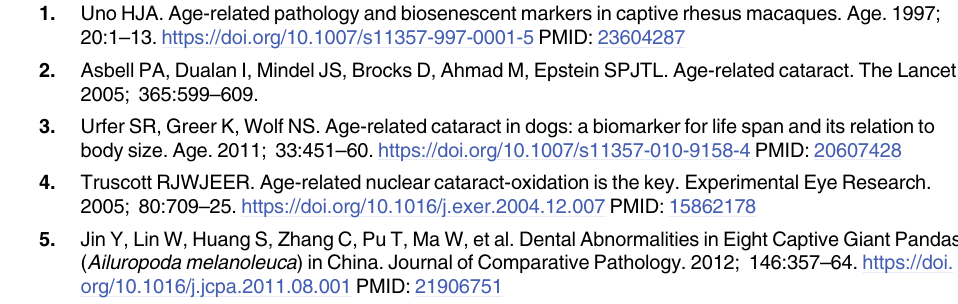
S1 Table. Methylation level of gene region. S2 Table. Genes associated with different methylation levels. S3 Table. KEGG enrichment of genes related to different methylation levels. S4 Table. GO enrichment of genes related to different methylation levels. S5 Table. Cataract related genes have been